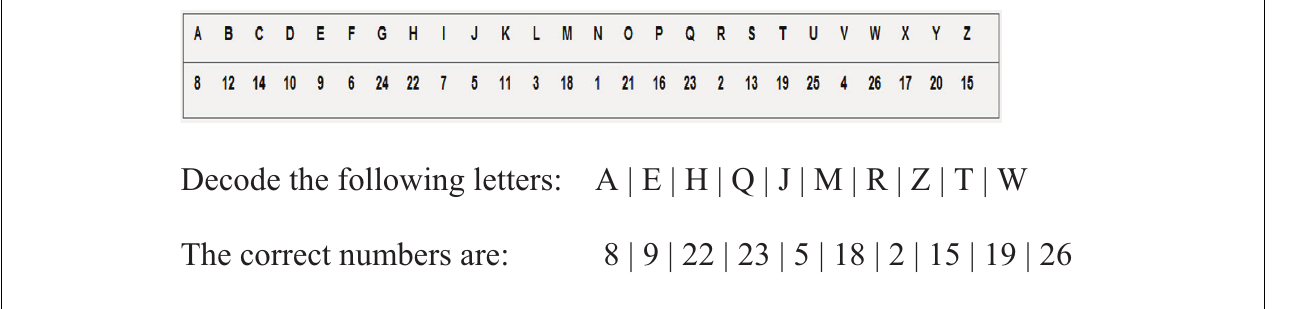
FIGURE 1 | Example of real effort